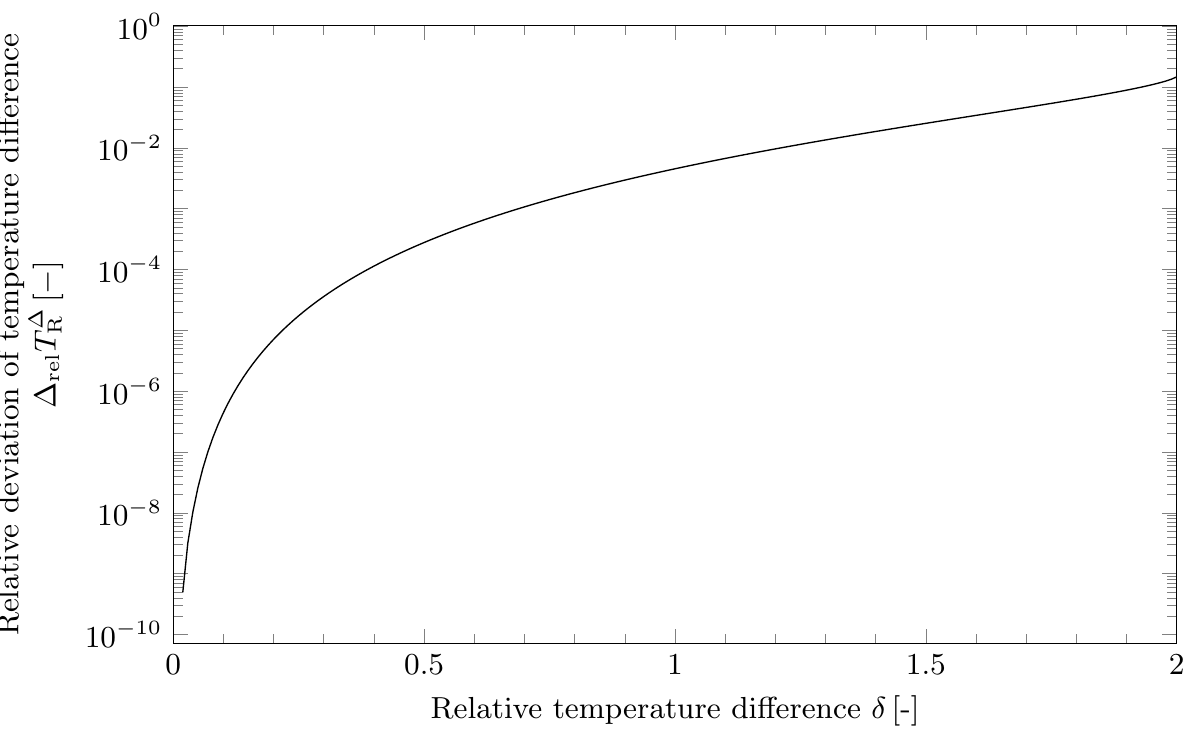
Figure 7. Relative deviation of the difference between the regenerator contact point temperatures from Equations (25) and (26) (caused by the approximation of the entropy expression) plotted against the exact relative temperature difference δ . For typical model situations with δ < 1.5, the caused relative deviation can be regarded as